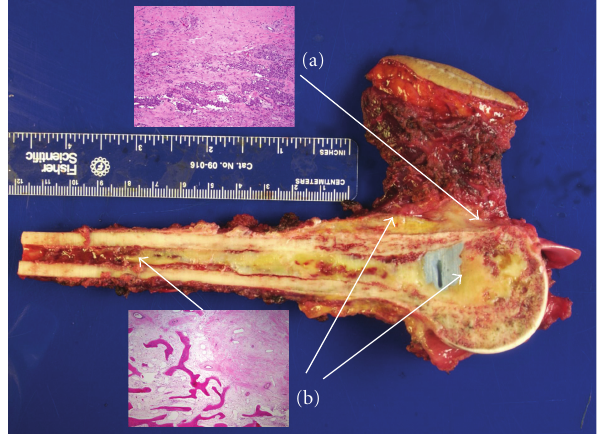
Figure 2: Gross specimen and whole-mount sections demonstrat- ing the areas of (a) necrosis and (b) residual